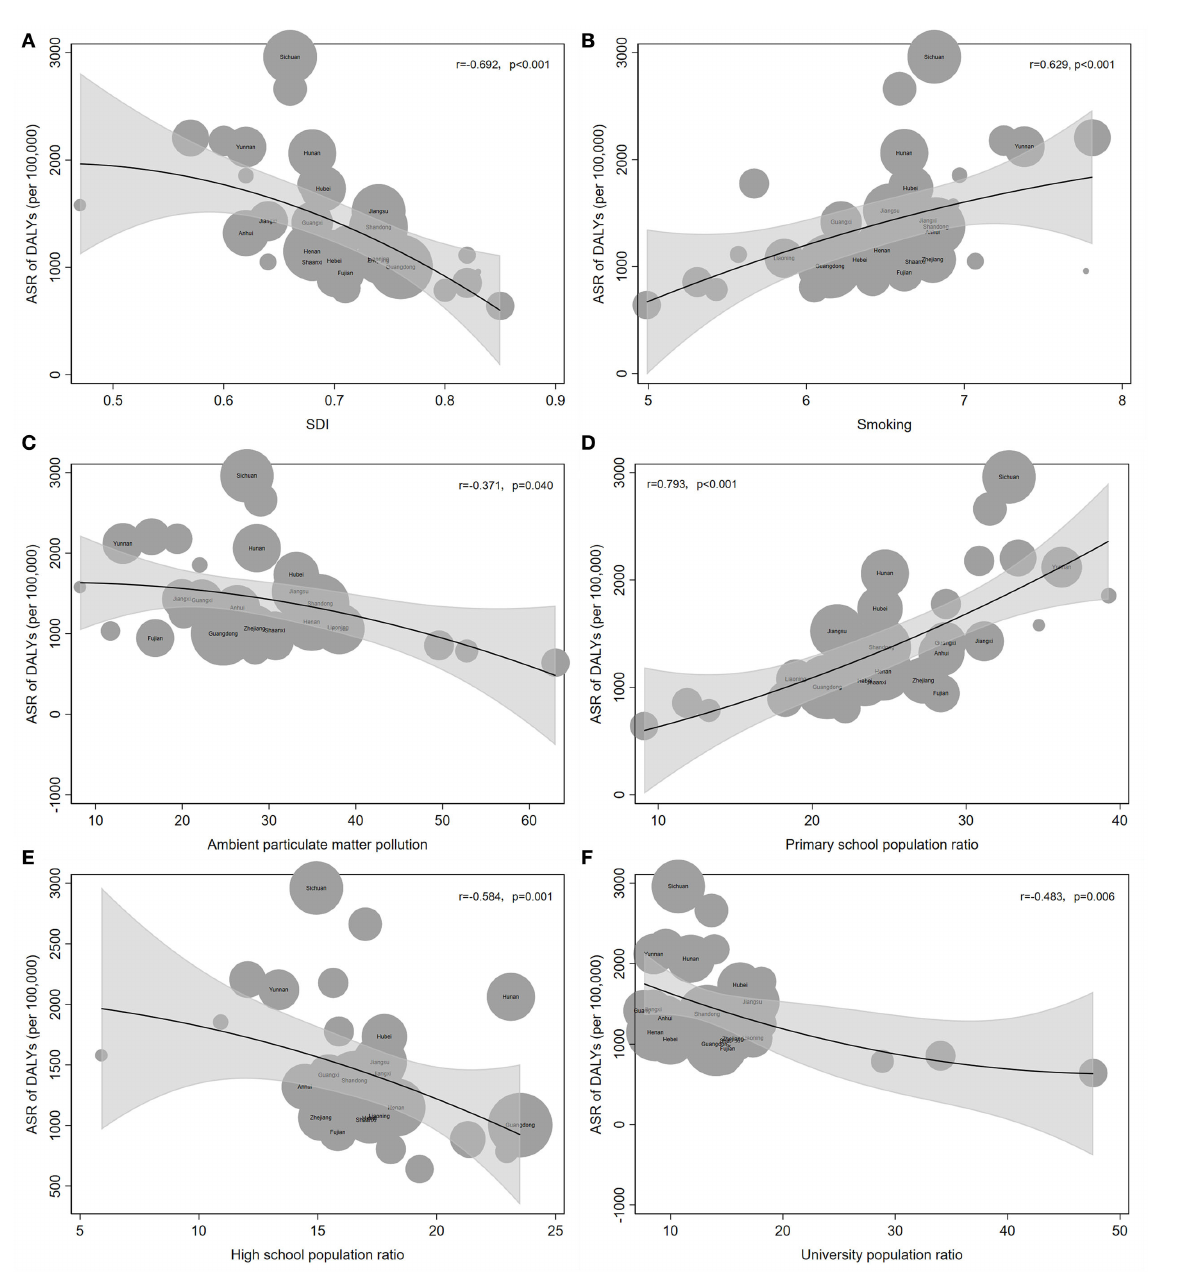
FIGURE4 Influencing factors for ASR of COPD DALY. (A) SDI and ASR of COPD DALY were negatively correlated. (B) Smoking was positively related to ASR. (C) Ambient particulate matter pollution was negatively correlated with ASR. (D) Primary school population ratio was positively correlated with ASR. (E, F) High school population ratio (E) and university population ratio (F) were both negatively correlated with